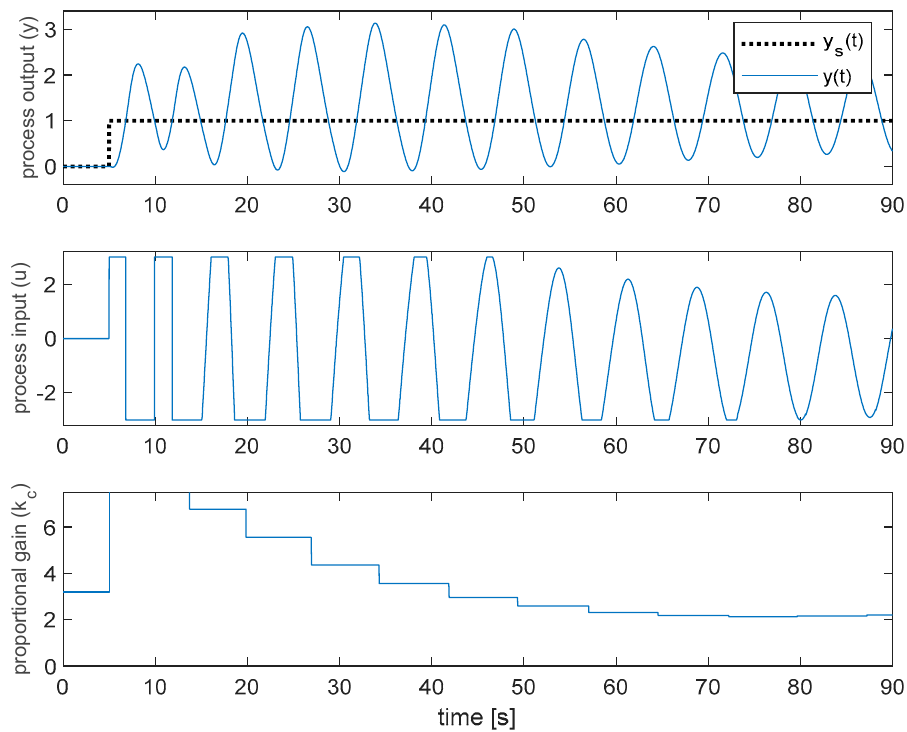
Figure 15. Response of the proposed method combined with the time delay [7] for the non-minimum phase process with θ = 0.1 and PA set = − 3 π /4 .